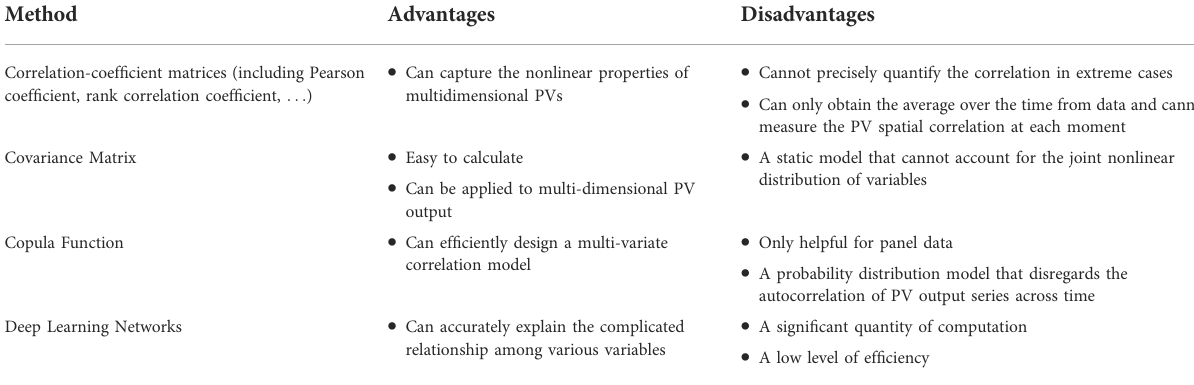
TABLE 1 Advantages and disadvantages of methods for constructing spatial correlation of PV output.